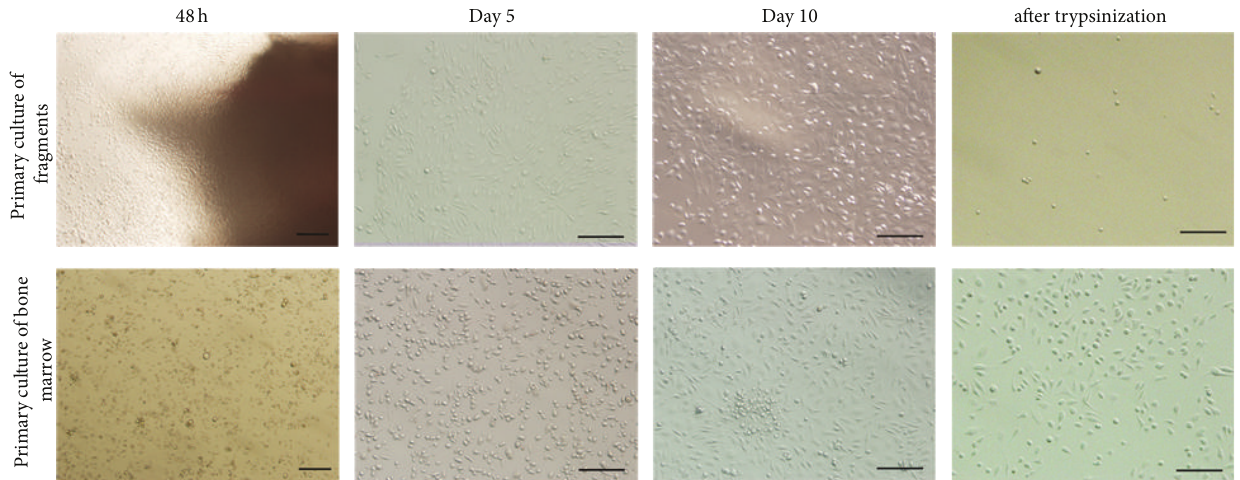
Figure 1: Morphology of primary cells from cultured bone marrow and bone fragments on days 2, 5, and 10 after plating. The residual cells adherent to plastic were observed after the trypsinization on day 10. Bar 100 𝜇 m.